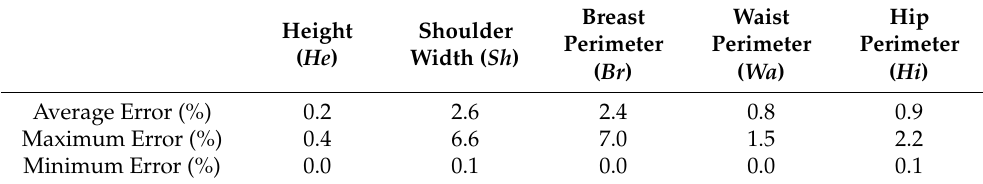
Breast Waist Hip Height Shoulder Perimeter Perimeter Perimeter ( He ) Width ( Sh ) ( Br ) ( Wa ) ( Hi )